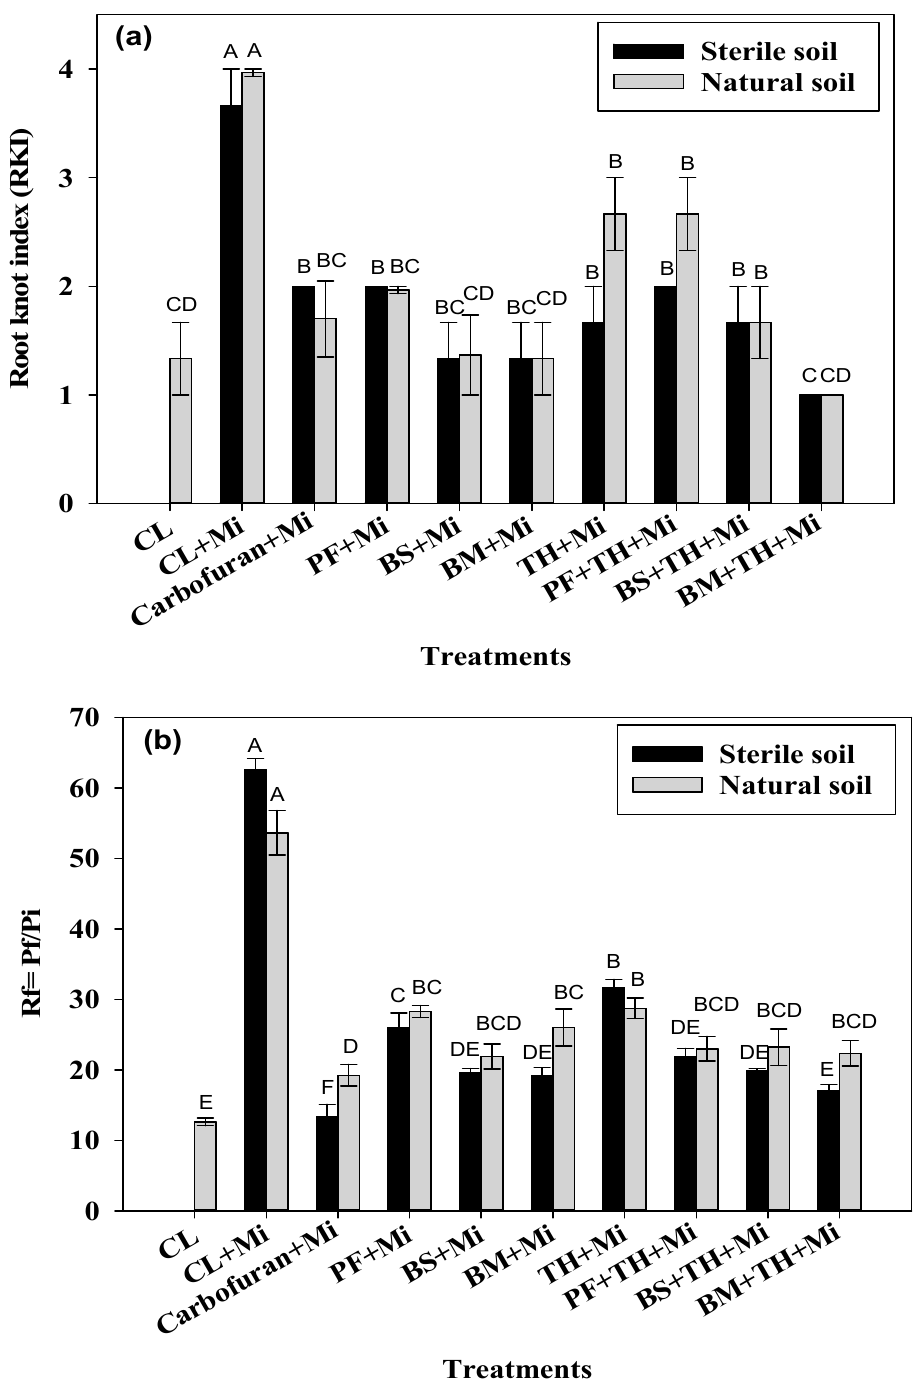
Figure 4. ( a ) Impact of different bioinoculants in single inoculations (BM + Mi, TH + Mi, BS + Mi, PF + Mi) and co-inoculations (BM + TH + Mi, BS + TH + Mi, PF + TH + Mi) on root knot index (RKI) in the rhizosphere of O. basilicum grown in sterile (black) and natural (grey) soil conditions. The comparisons were made for all of the treatments of the same experiment, either in sterile soil or natural soil conditions. Error bars (mean ± SE) with different letters represent statistically significant values (at p ≤ 0.001) in comparison to untreated inoculated control (CL +Mi). ( b ) Impact of different bioinoculants in single inoculations (BM + Mi, TH + Mi, BS + Mi, PF + Mi) and co-inoculations (BM + TH + Mi, BS + TH + Mi, PF + TH + Mi) on reproduction factor (Rf) in sterile (black) and natural (grey) soil